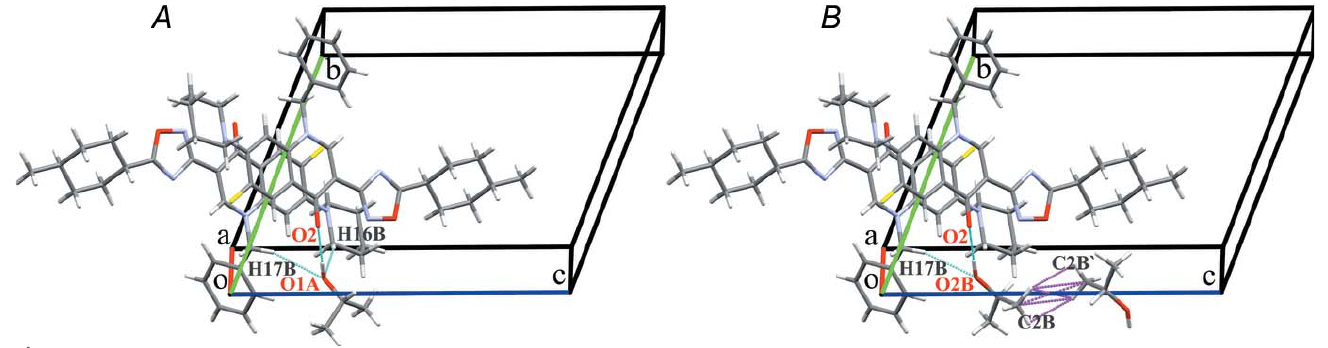
Figure 3 Comparison of hydrogen bonds (in cyan) and short contacts (in magenta) of the 2-propanol molecules in positions A and B